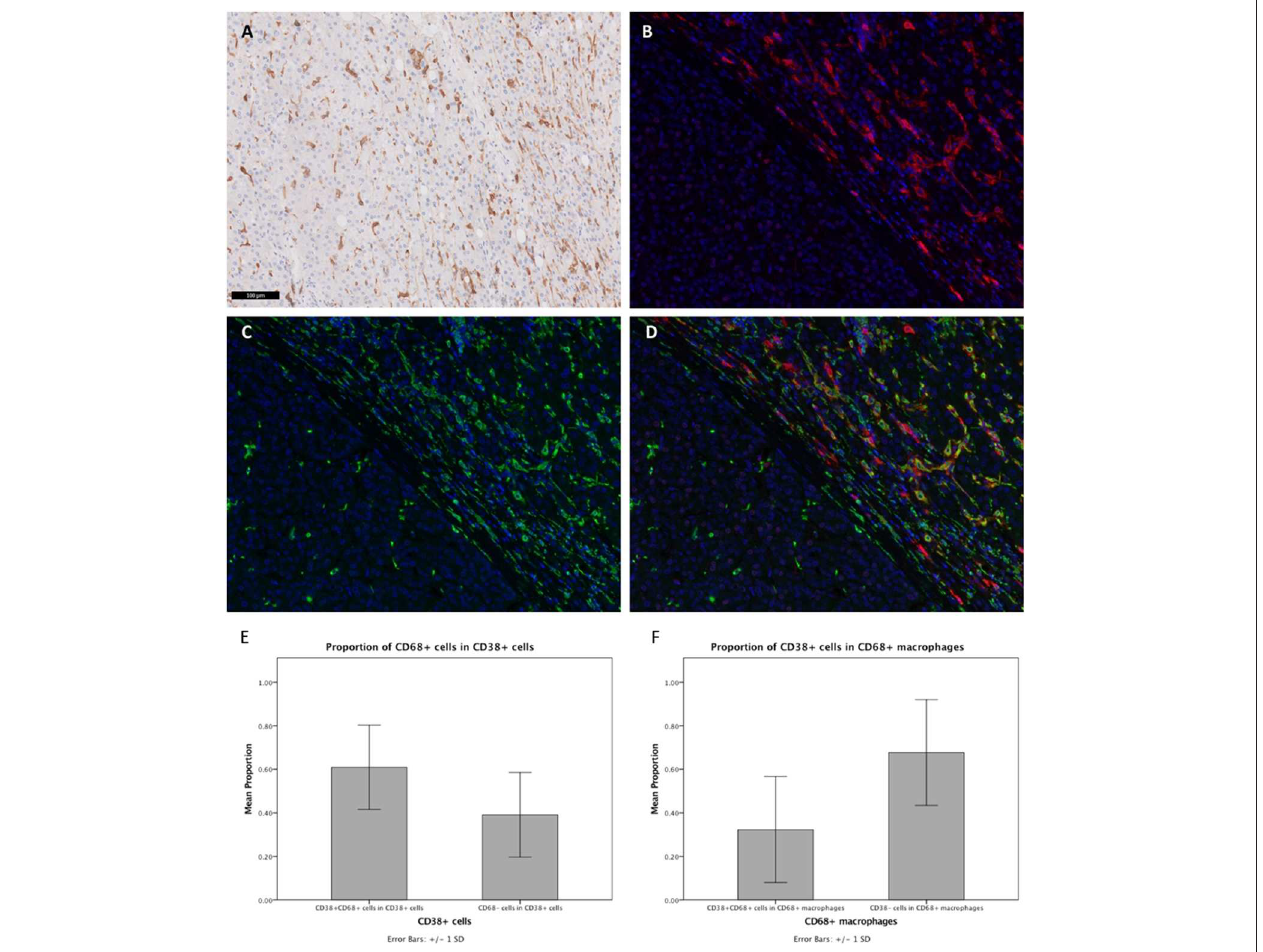
FIGURE 1 | Expression of CD38 by TAMs from HCC patients was visualized by IHC. (A) Conventional IHC staining of a representative FFPE tumor section revealing the presence of macrophage-like cells (brown) in the liver sinusoids. (B,C) Immunofluorescent staining for CD38 (red) and macrophage marker CD68 (green), respectively, on tumor section. (D) Merged image showing co-localization of CD38 (red) and CD68 (green) in the tumor microenvironment. Images are presented at 40 × magnification. (E) Proportions of CD38 + CD68 + and CD38 + CD68 − leukocytes. (F) Proportions of CD38 + CD68 + and CD38 − CD68 + macrophages. Data is presented as the mean ± standard